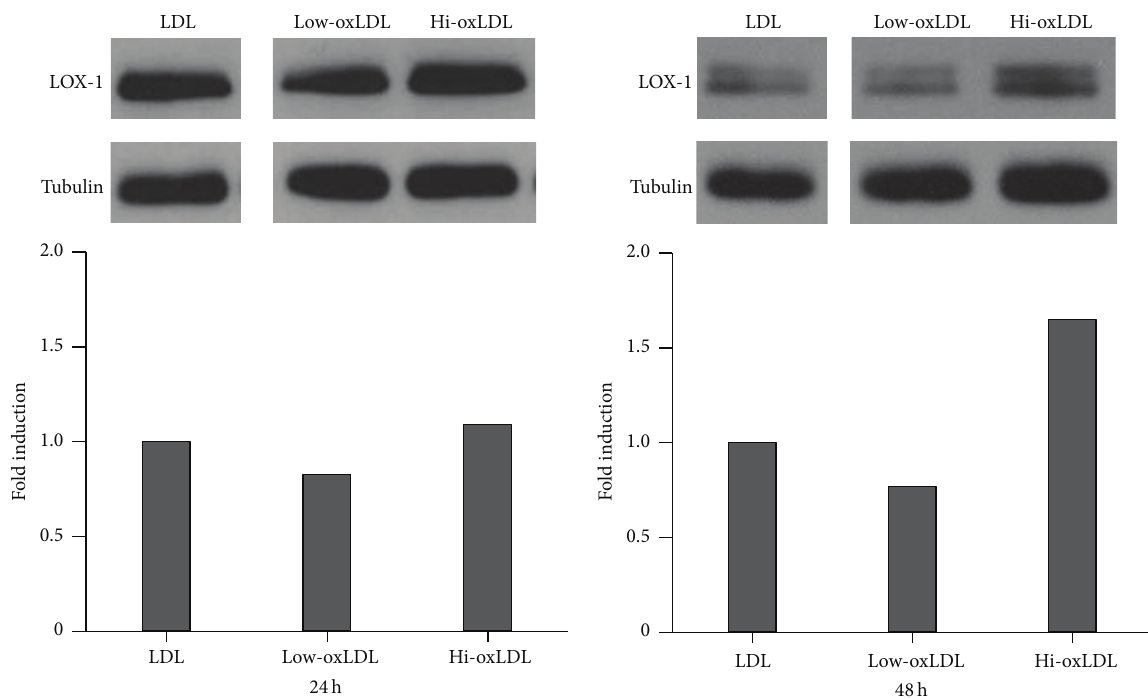
Figure 4: Expression of LOX-1 in response to oxLDL. THP-1 cells were treated with differentially oxidized LDL (50 𝜇 g/mL) for 24 or 48 h. Each 50 𝜇 g of protein samples was loaded and analyzed with anti-LOX-1 antibodies and anti-tubulin antibodies (internal